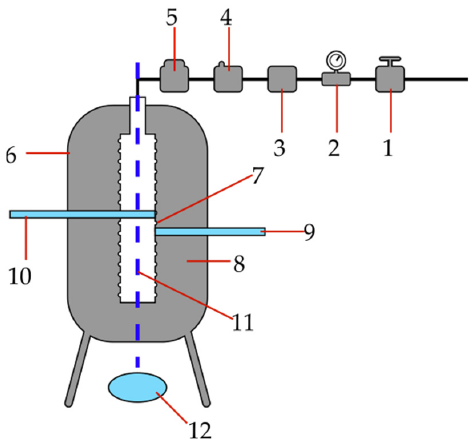
Figure 7. Scheme of measurement equipment for minimum ignition temperature of a tobacco dust cloud [7]: (1) stopstock, (2) pressure gauge, (3) pressure vessel, (4) electromagnetic valve, (5) dust-sample container, (6) furnace shell, (7) heating, (8) thermal insulation materials, (9,10) thermocouples, (11) quartz furnace tube, and (12) reflector.